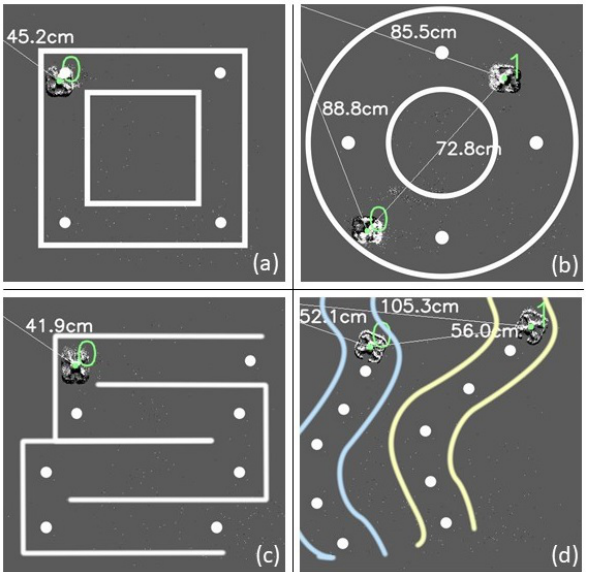
Figure 4. Path planning experiment scenarios with multiple quadrotors viewed from above. ( a ) Square path, ( b ) circle path, ( c ) lawnmower path, and ( d ) cubic spline path. A flight safety corridor (as indicated by solid lines) was defined to enclosed all waypoints. Each quadrotor was commanded by the motion planner to stay within this predefined flight corridor as it traversed the